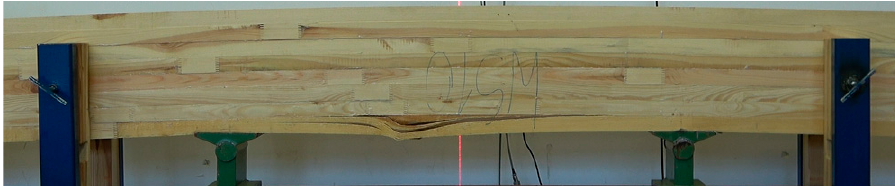
Figure 11. Damage image of beam type WS_M, f m = 45.2 MPa.